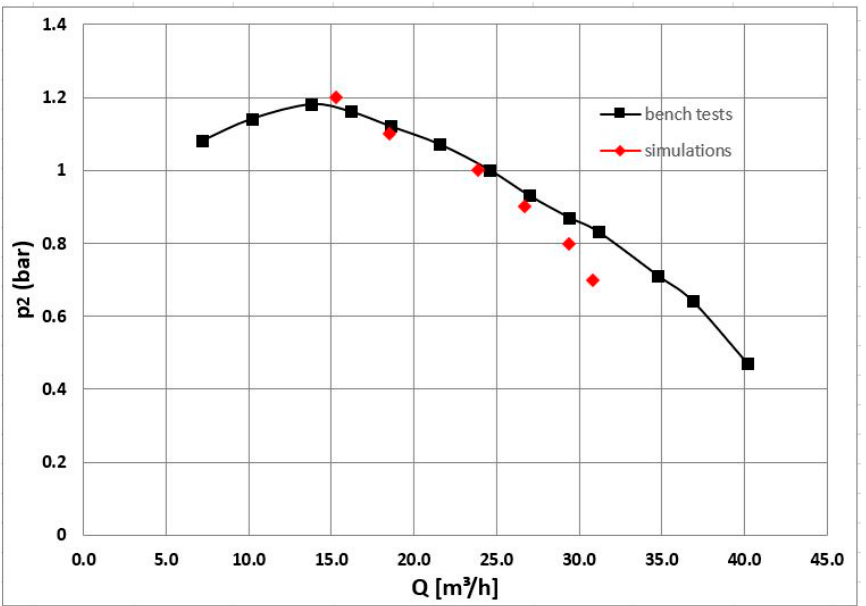
. Q volume flow in the impeller